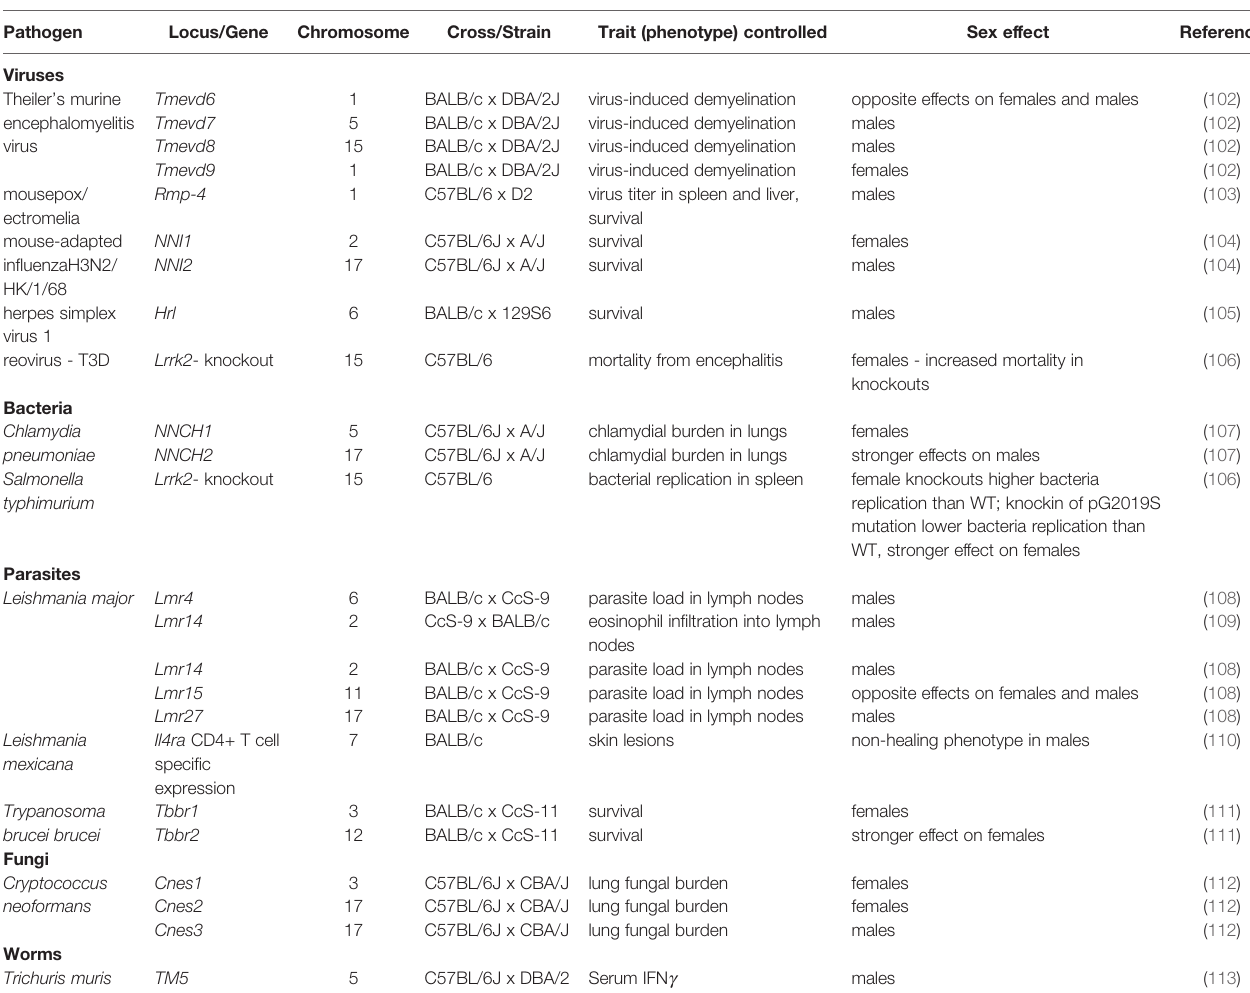
The Table summarizes position on chromosome, cross used to map certain locus or mouse genetic background, disease phenotype controlled and sex effect. Cnes, Cryptococcus neoformans susceptibility; Hlr, herpes resistance locus; Il4ra, interleukin 4 receptor alpha; Lmr, Leishmania major response; Lrrk2, leucine-rich repeat kinase-2; NNCH, not named Chlamydia; NNI, not named in fl uenza; Rmp-4, Resistance mousepox 4; Tbbr, Trypanosoma brucei brucei response; TM, Trichuris muris; Tmevd, Theiler ’ s murine encephalomyelitis virus-induced